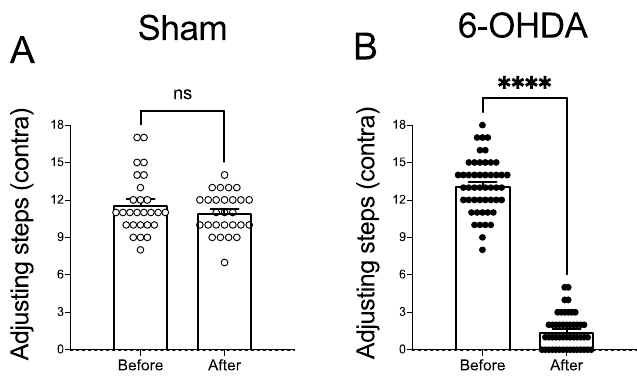
Figure 1. Evaluation of the stepping test before and after surgery for the unilateral vehicle or 6-OHDA infusion into the right MFB. ( A ) Administration of the vehicle into the right MFB bundle did not affect the stepping test ( p > 0.05; paired t -test). ( B ) 6-OHDA microinjection into the right MFB significantly decreased the number of adjusting steps performed with the contralateral forelimb (**** p < 0.0001; paired t ‐ test). Data expressed as mean ± SEM. Results are derived from a total of n = 23 Sham ‐ operated and n = 51 6 ‐ OHDA ‐ lesioned rats.